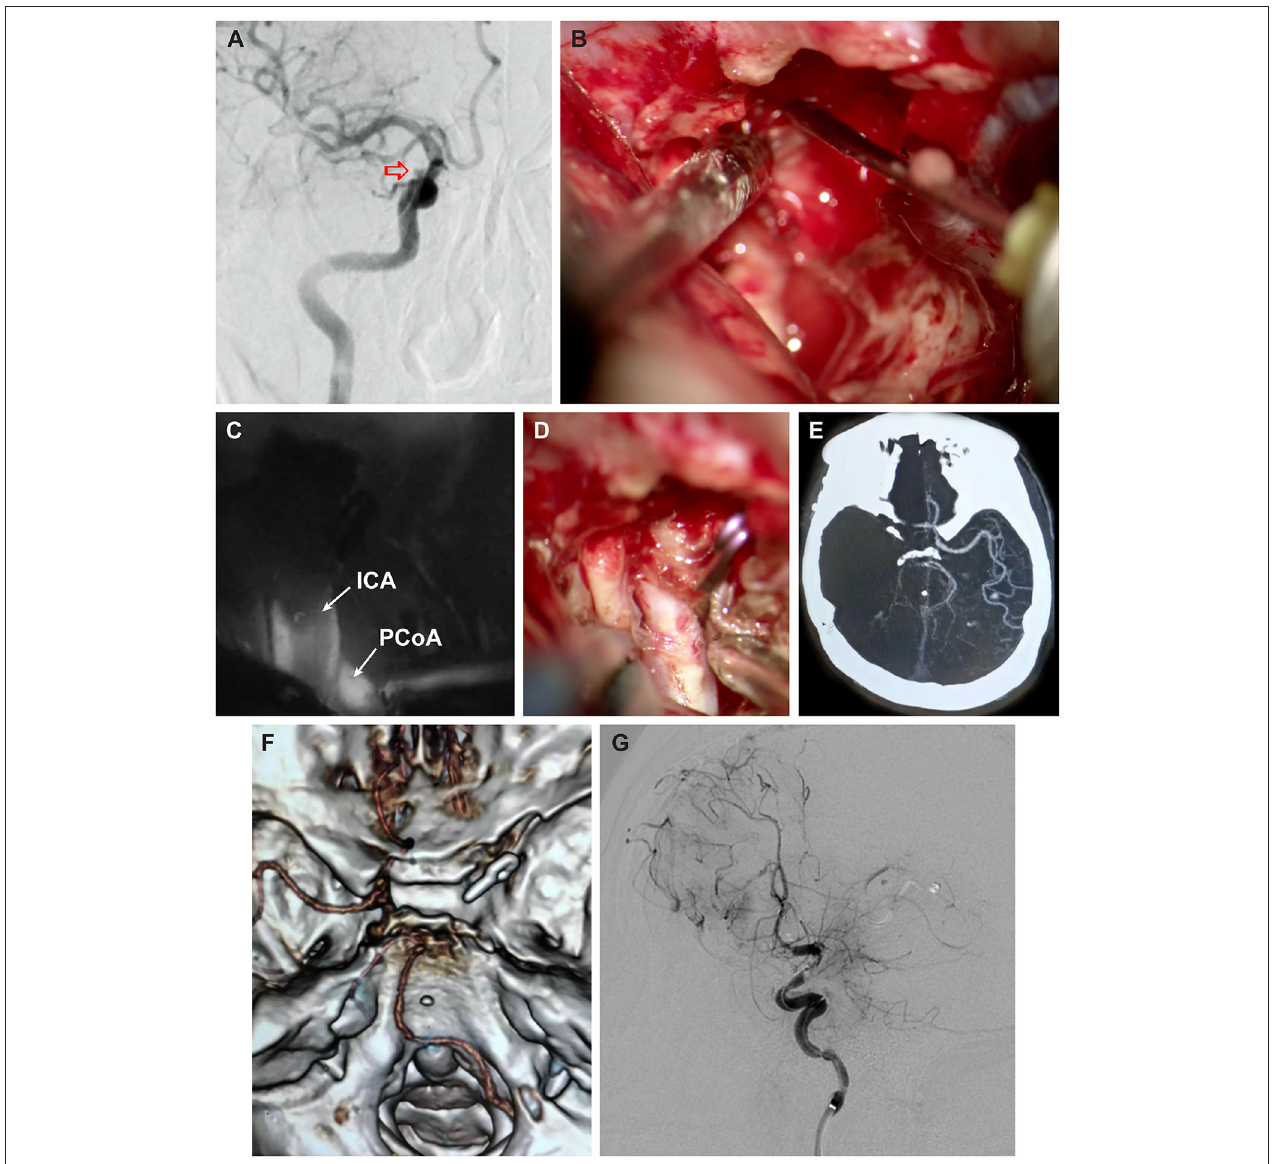
FIGURE 1 | Case 1. (A) Digital subtraction angiography (DSA) oblique view demonstrating small unruptured aneurysm ( red arrow ) in the transition between the cavernous and clinoidal segments of the right internal carotid artery (ICA). (B) Intraoperative photograph of direct injection of fibrin glue into the cavernous